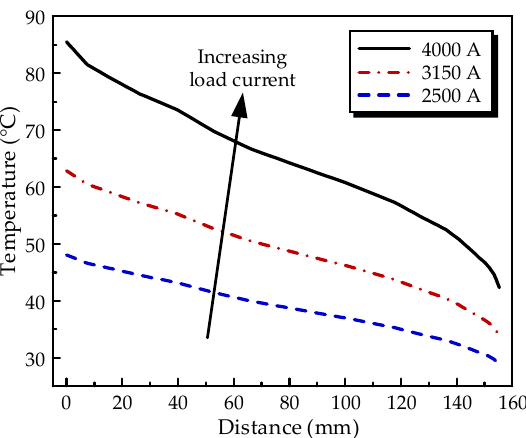
Figure 13. Surface temperature distribution along the spacer surface with different load currents.